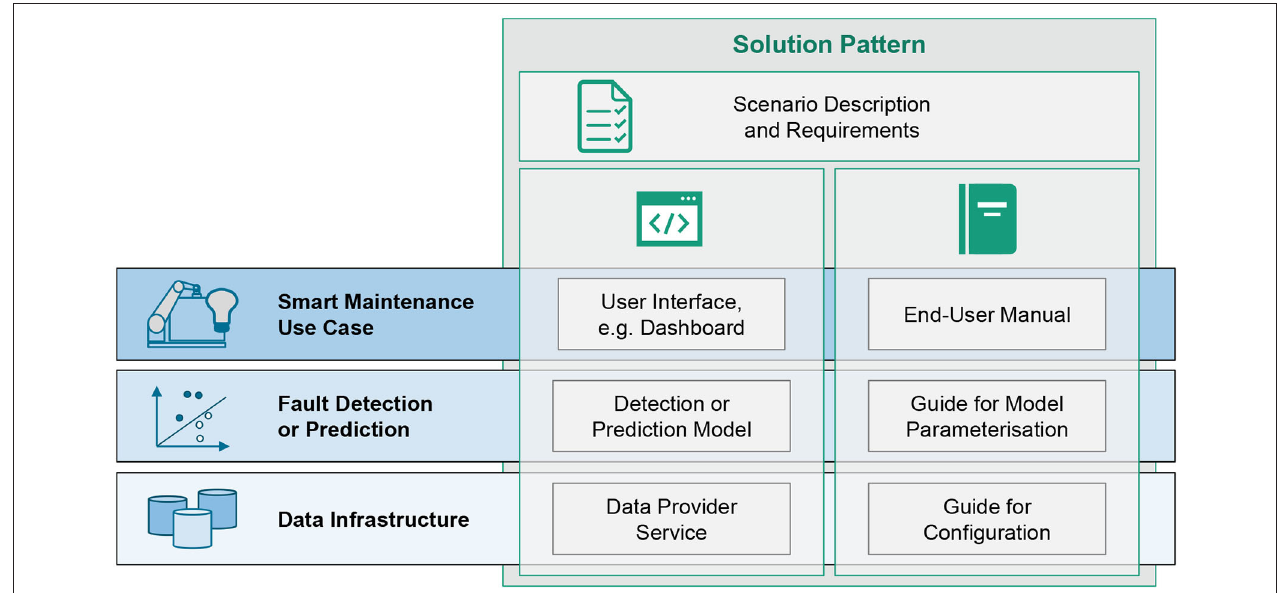
FIGURE 10 | Components of a smart maintenance solution